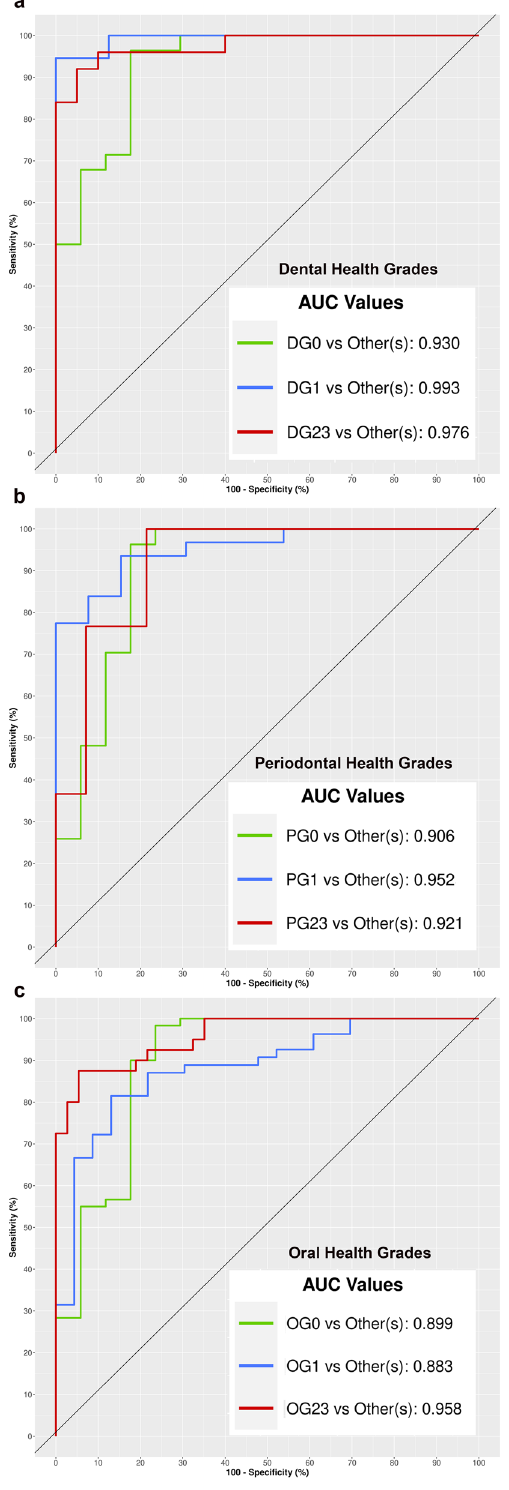
Figure 7. Potential of the salivary microbiome to discriminate the different grades of dental and periodontal health and the combination of both: ROC curves and AUC values (graphics made using the MixOmics package, version